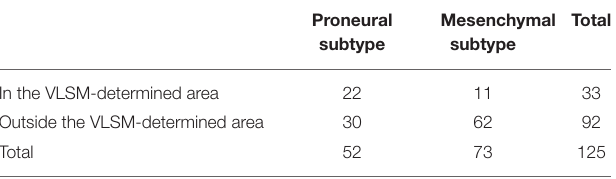
TABLE 2 | The distribution of proneural and mesenchymal subtypes in and outside the VLSM-determined